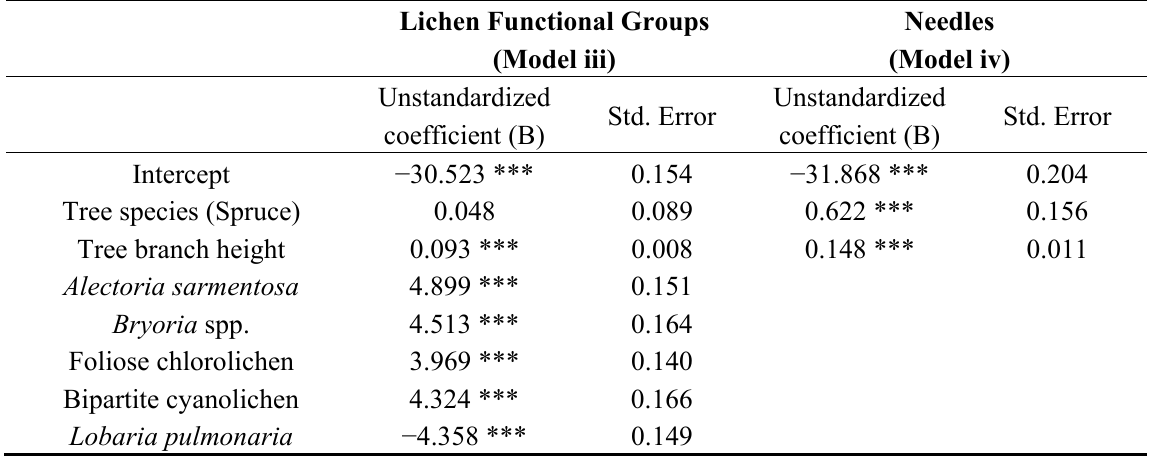
Table 3. Linear regression (OLS) coefficients with standard error for the regression model predicting δ 13 C in lichen functional groups (F = 711.517, p < 0.001, R 2 = 0.942) and needles (F = 79.545, p < 0.001, R 2 = 0.724) based on tree species (spruce), tree branch height and lichen functional